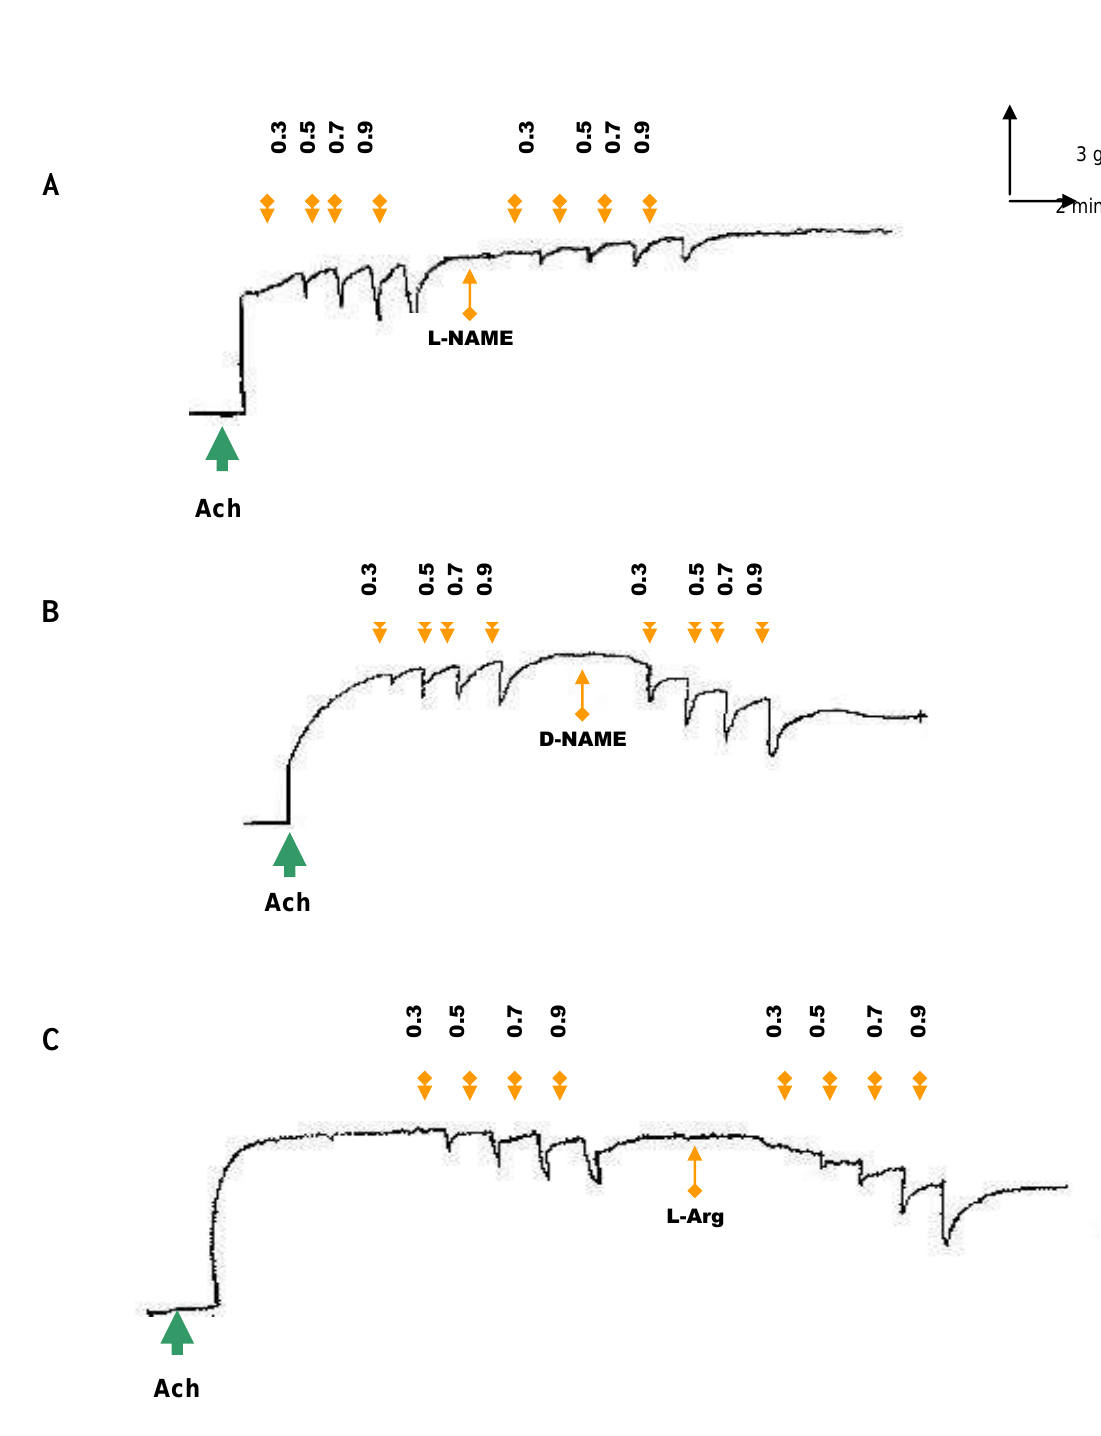
Figure 3 : Effects of L-NAME (A. 100 uM), D-NAME (B. 100 uM) and L-Arg (C, 10 uM) on the Cordia myxa extract -induced relaxation of tracheal